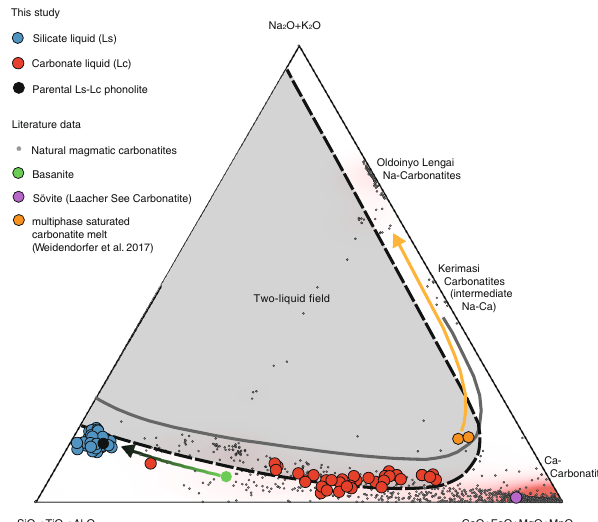
Fig. 5 Ternary plot of natural and experimental data. Hamilton projection 70 i.e. ternary plot with CaO + MgO + FeO vs SiO 2 + Al 2 O 3 + TiO 2 vs Na 2 O + K 2 O (in wt%) of the conjugating immiscible silicate (Ls) and carbonate liquid (Lc) from this study. Also plotted: calculated parental phonolite (Table 1), Sövite (Laacher See Carbonatite 52 , and Weidendorfer et al. ’ s 60 Ca-carbonatitic parental “ multiphase ” composition (100 MPa at 1000 and 1050 °C) with liquid line of descent 60 (orange line). The dashed line is the estimated binodal from this study, the solid line is the binodal determined by Kjarsgaard 37 for CaO- rich nepheline at 200 MPa. For comparison, compositions of natural magmatic carbonatites 57 with compositions taken from the GEOROC (Geochemistry of Rocks of the Oceans and Continents) database (http:// georoc.mpch-mainz.gwdg.de/georoc/) are plotted. The heat map (highlighted in red) shows relative distribution of magmatic carbonatite compositions. Also shown is the indicated differentiation path from mantle- derived basanitic (green circle) to phonolitic magma 41,44 .